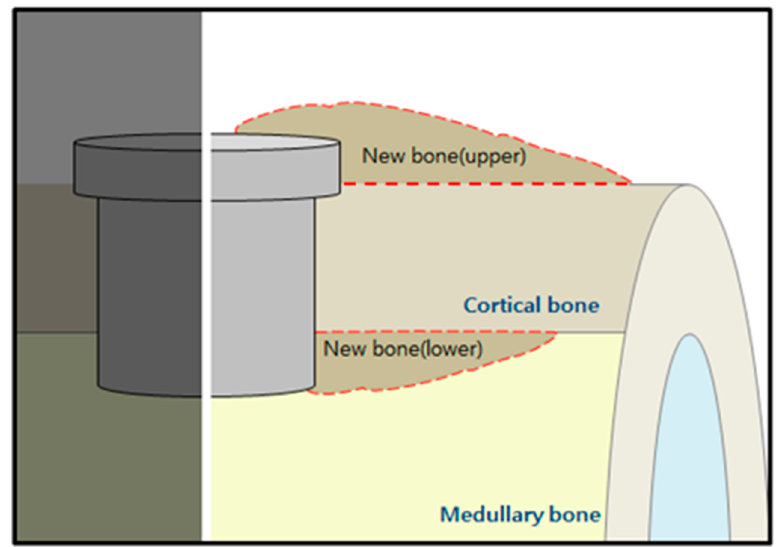
Figure 2. Schematic diagram depicting the measuring parameters (newly formed bone: upper and lower).